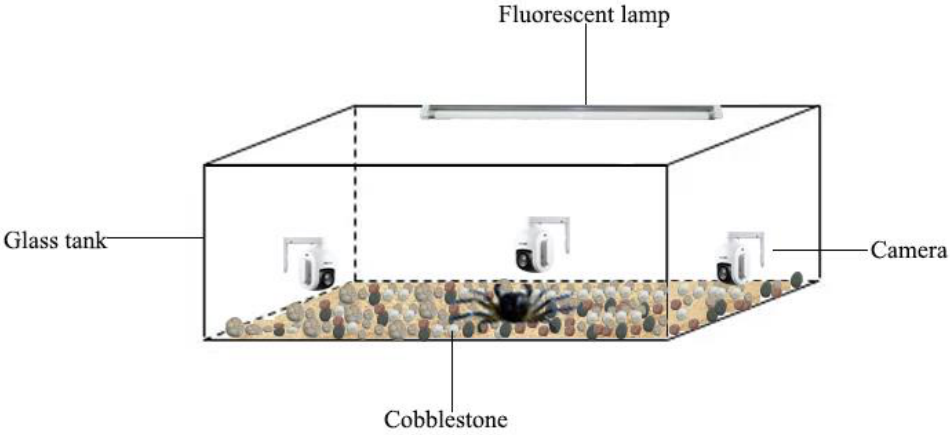
Figure 1. The experiment device of behavior observation.